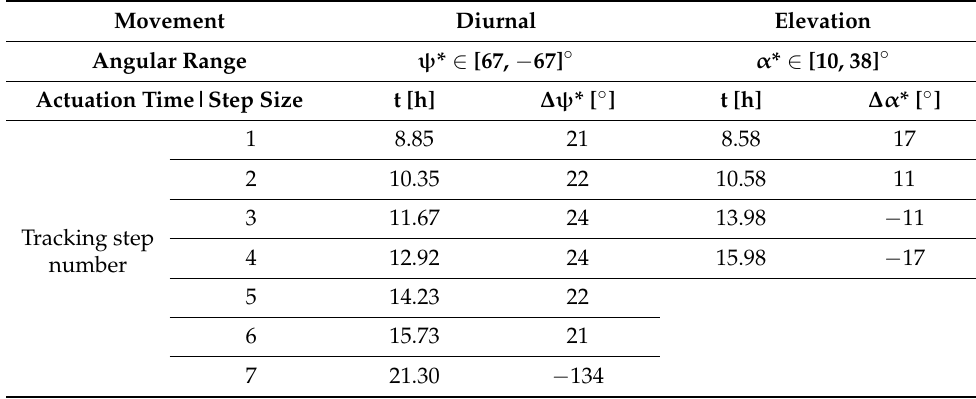
Table 3. Tracking program